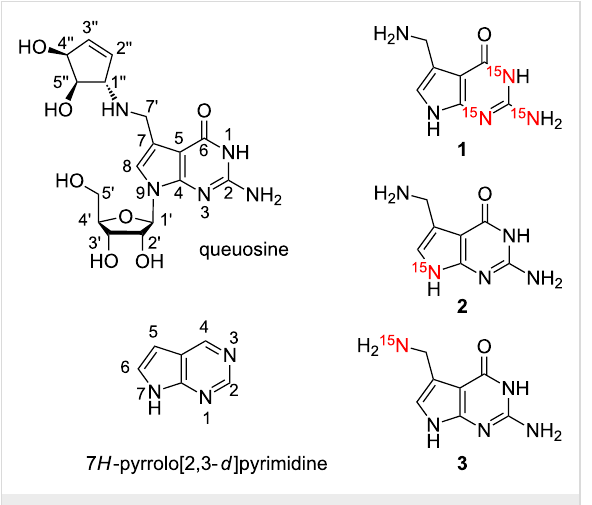
Scheme 1: The hypermodified nucleoside queuosine (Q) and the syn- thetic targets of preQ 1 bases 1 to 3 with complementary 15 N labeling patterns for potential NMR spectroscopic applications. Purine and systematic numbering as indicated.